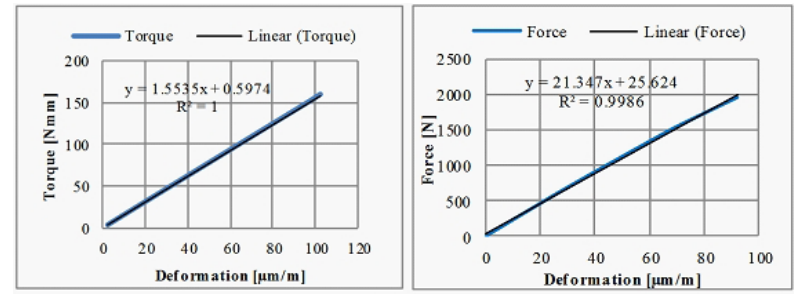
Figure 14. Calibration chart for torque and force measurement.